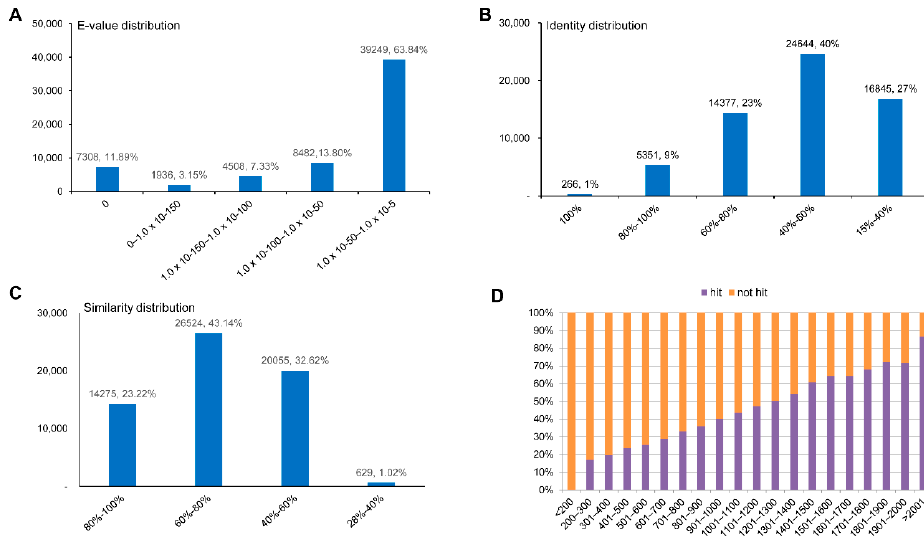
Figure 4. PANM-DB homology classification of A. chejuensis unigenes. ( A ) E -value distribution; ( B ) Identity distribution; ( C ) Similarity distribution; ( D ) Unigene hit or non-hit